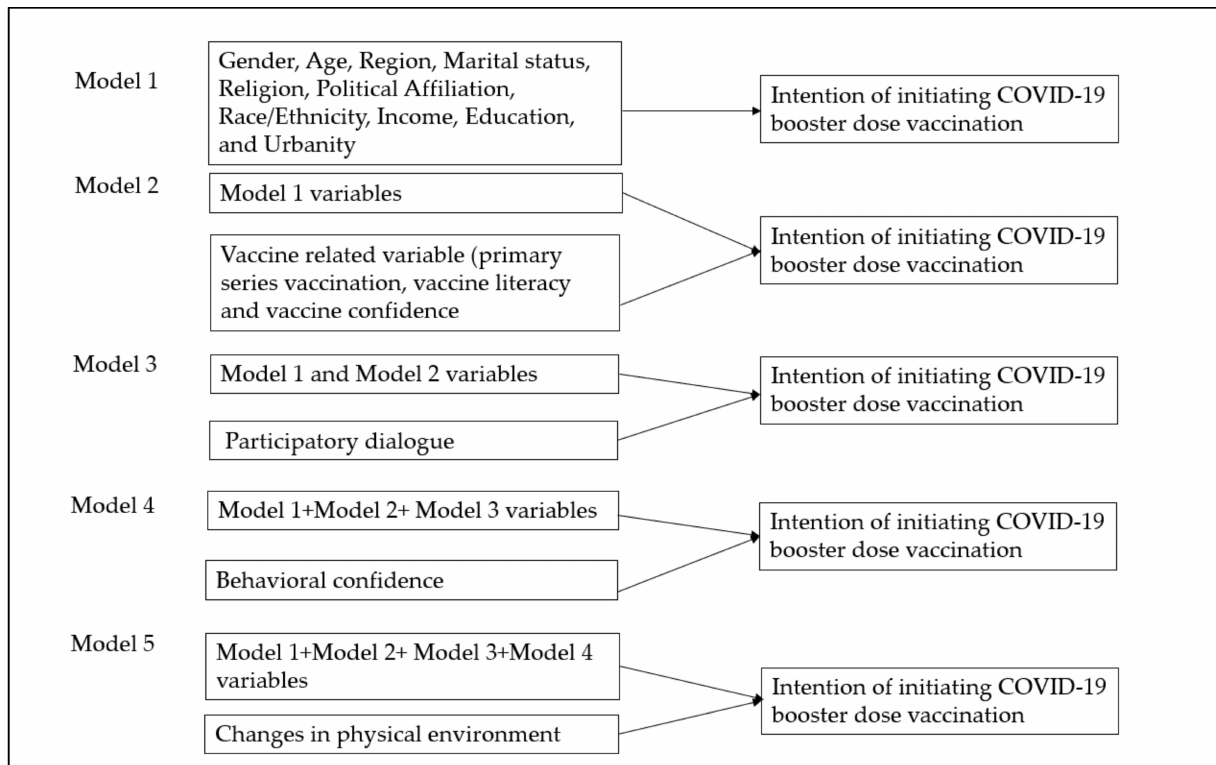
Figure 1. Hierarchical regression model building